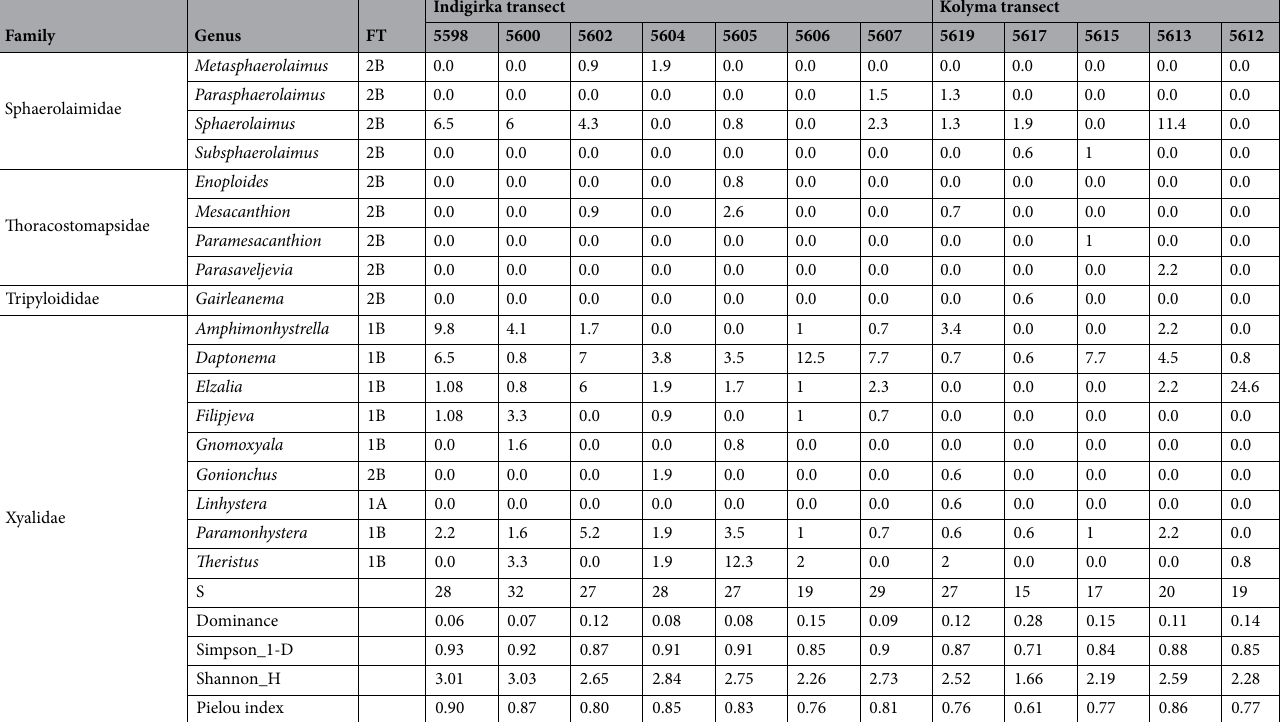
Table 2. Percentage abundance of nematode genera, their feeding type (FT) and diversity indexes. Stations are indicated in the top line in bold. Number of genera—S.